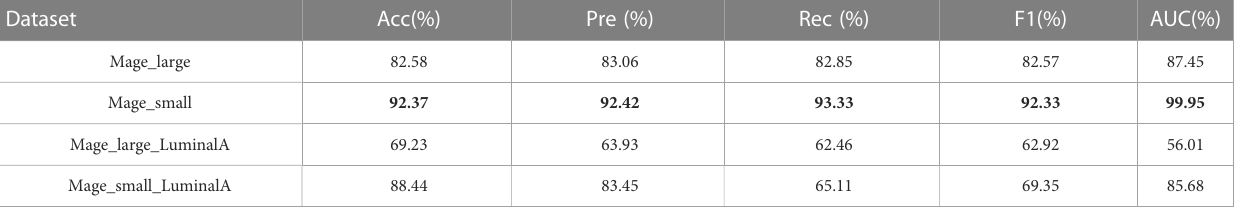
TABLE 6 Diagnostic performance of CAMBNet for differentiating molecular subtypes based on menarche age. Dataset